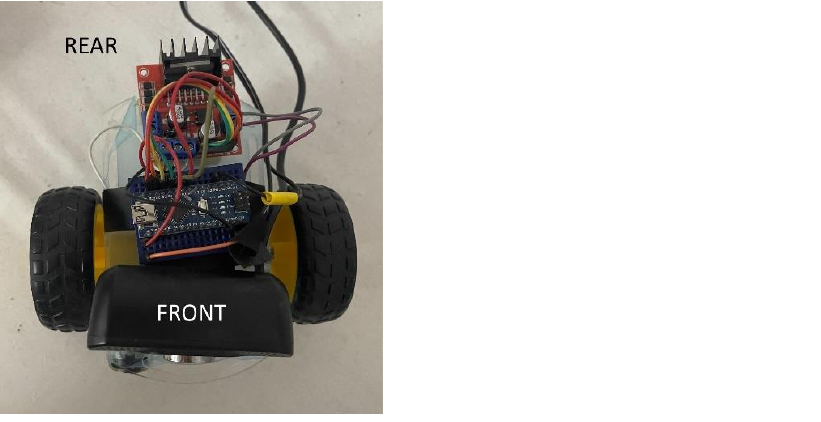
Figure 2. I/O data collected from the closed-loop visual servo system. Figure 3. Data used for validating the identified closed-loop visual servo system model ( 𝜌 𝑘 -red, 𝑦 𝑘 - black).